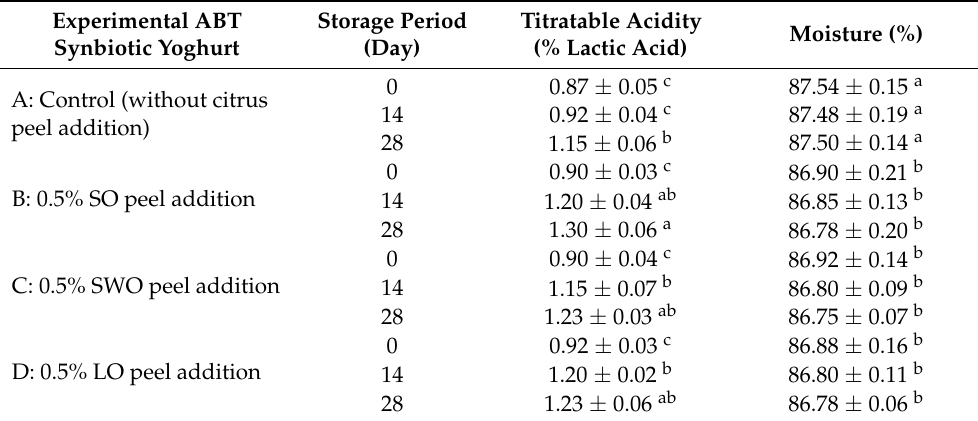
Table 2. Titratable acidity and moisture of ABT synbiotic yoghurt with citrus peel addition during cold storage (5 ± 1 ◦